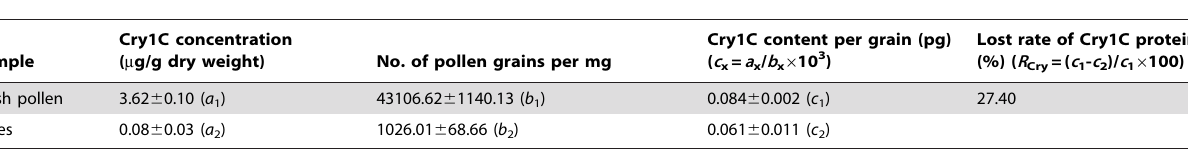
Table 2. Cry1C protein content of rice pollen grains before and after passage through the digestive system of Bombyx mori larvae.